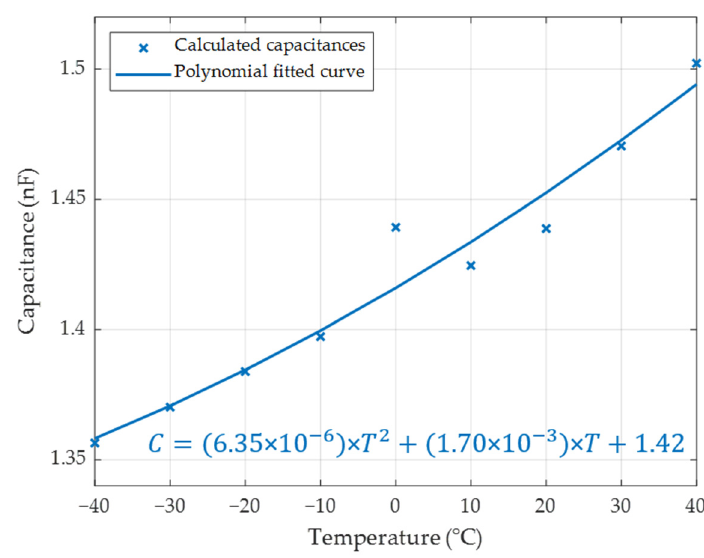
Figure 6. Capacitance variation with temperature change.